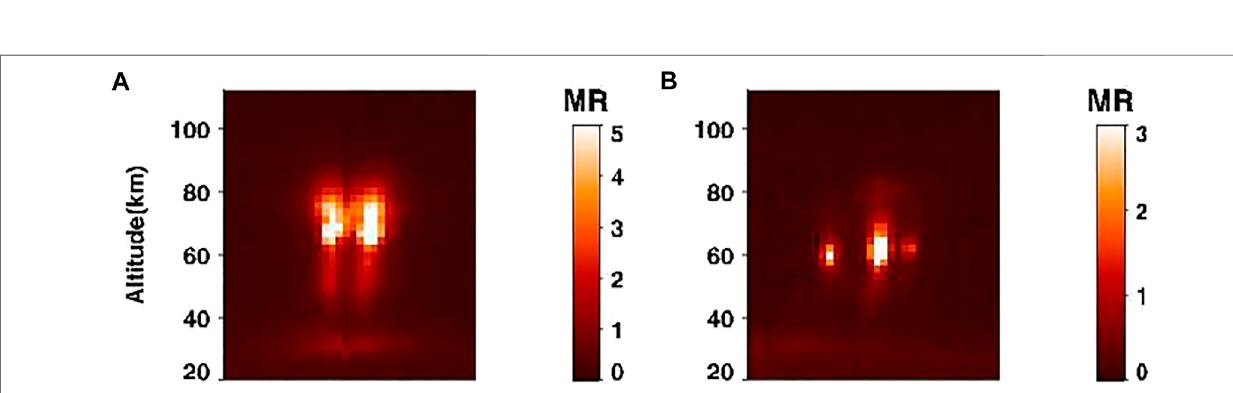
Frontiers in Earth Science |